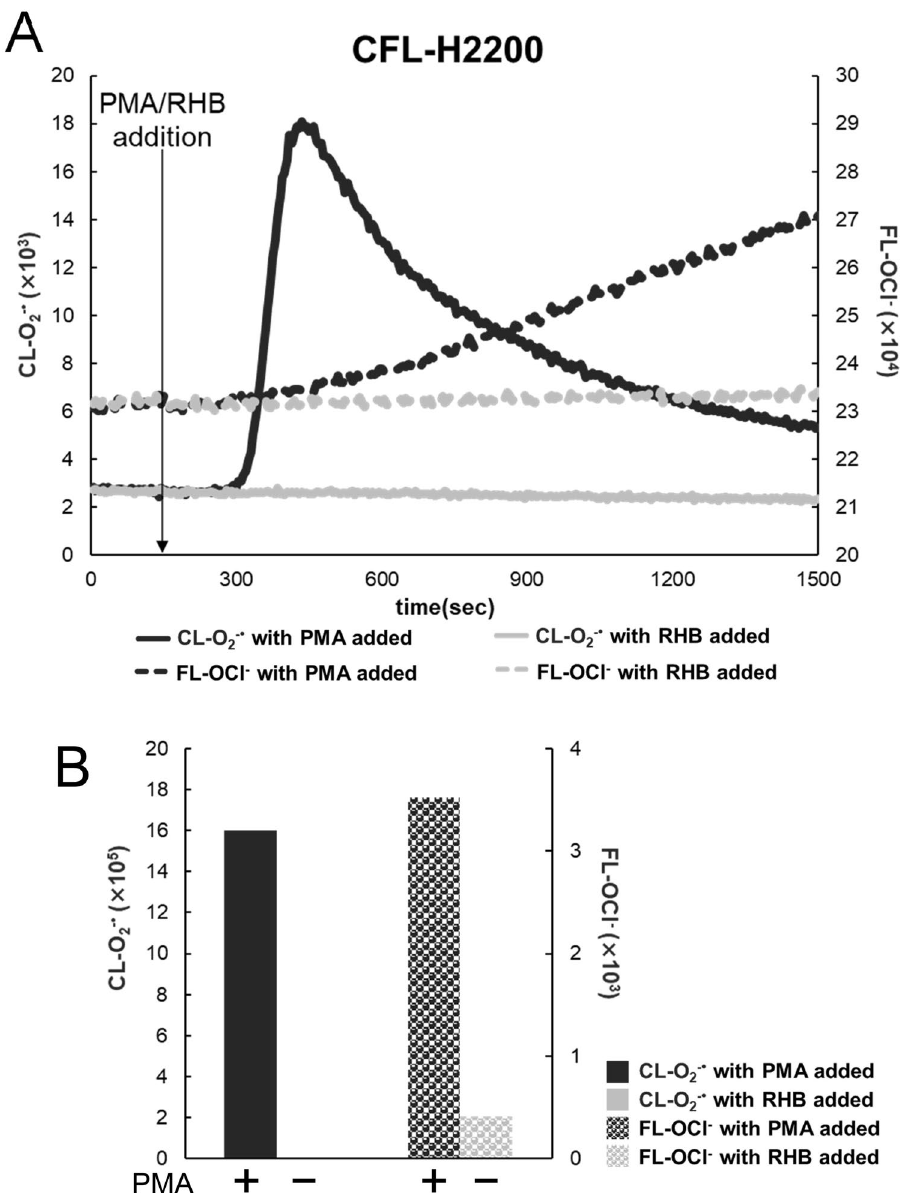
of CL-O 2−· (solid lines) and FL-OCl − (dotted lines) in blood obtained by CFL-H2200. The left vertical axis shows CL-O 2−· intensity; the right vertical axis, FL-OCl − intensity. PMA (dark lines) or RHB (light lines) was added at 150 s (arrow line). The baseline heights of FL-OCl − were adjusted at the same level. ( B ) Baseline-subtracted total amount of CL-O 2−· and FL-OCl − with and without PMA calculated from the data in ( A